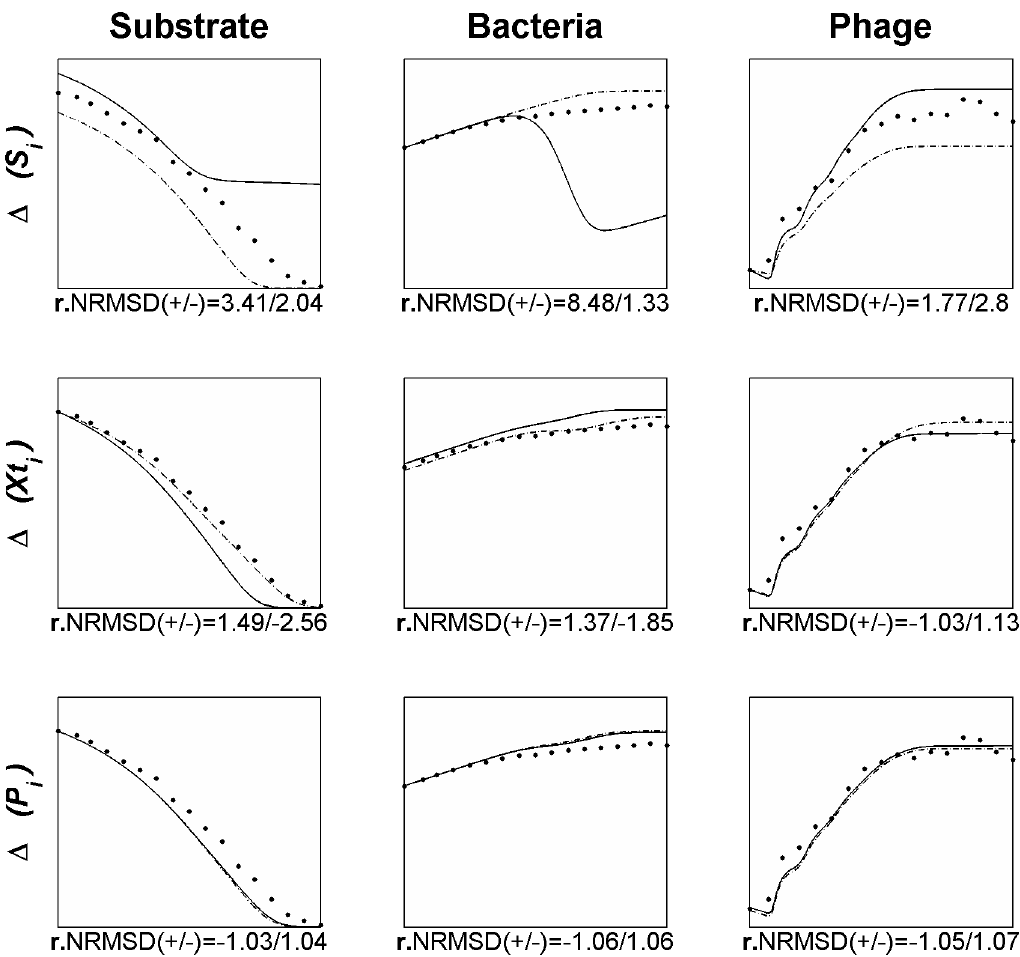
Figure 8. Variations in the model simulation when varying each of the state variables alone in 10% (using as the base case the data from Figure 5). Legend: N experimental data; ___ model simulation when increasing the variable in 10%; - . - model simulation when decreasing the variable in 10%. The text on the left side of each line graph identifies the variable being analysed. D (S i ) : variation in initial substrate concentration, D (Xt i ) : variation in initial total bacteria concentration, D (P i ) : variation in initial free phage concentration. The x- and y-axis are the same as Figure 5 (x: time [1 8] hours, y Substrate : [0 5000]; y Bacteria : [10 7 10 10 ]; y Phage : [10 5 10 12